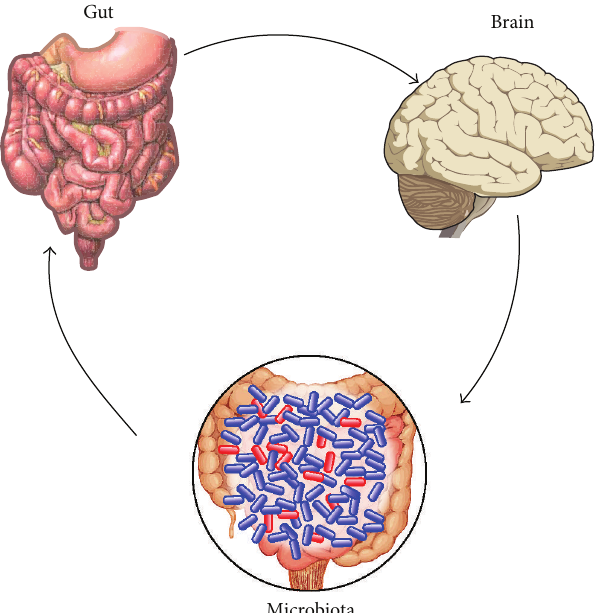
Figure 5: The interconnection of the gut, brain, and microbiota.